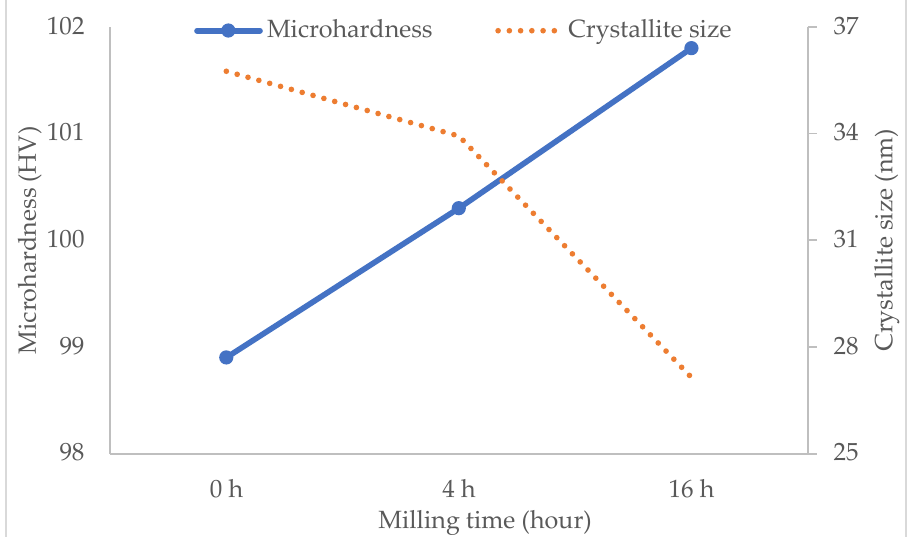
Figure 20. Inverse correlation of microhardness and crystallite size via increasing milling time. AA2024 powders have a unique and non-spherical powder morphology. Type 1 (3)